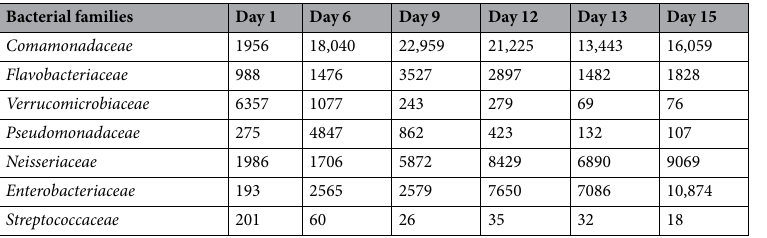
Table 2. OTU counts of bacterial families in serially passaged electro-bioreactor operated at CD of 3 Am − 2 .